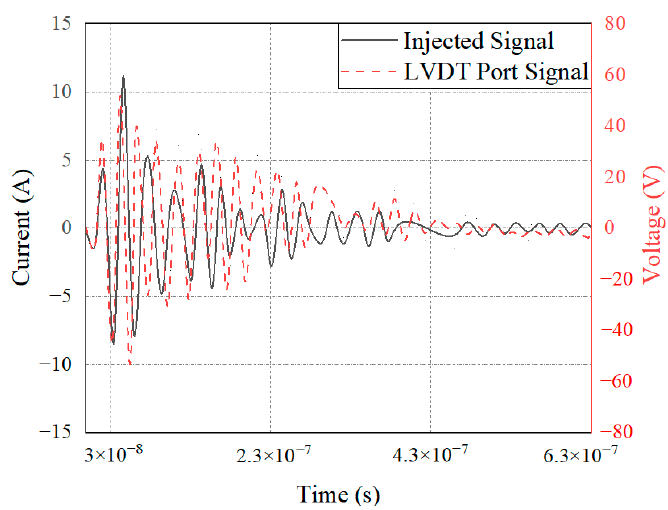
Figure 18. LVDT terminal coupling voltage signal.